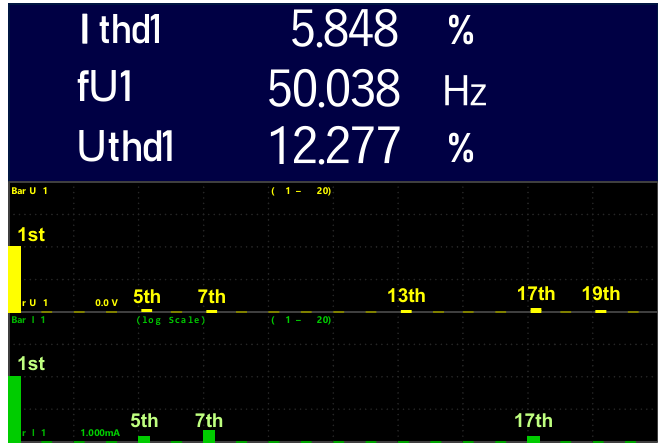
Figure 11 Figure 11. Harmonic spectrum of load current (yellow) and line to line voltage